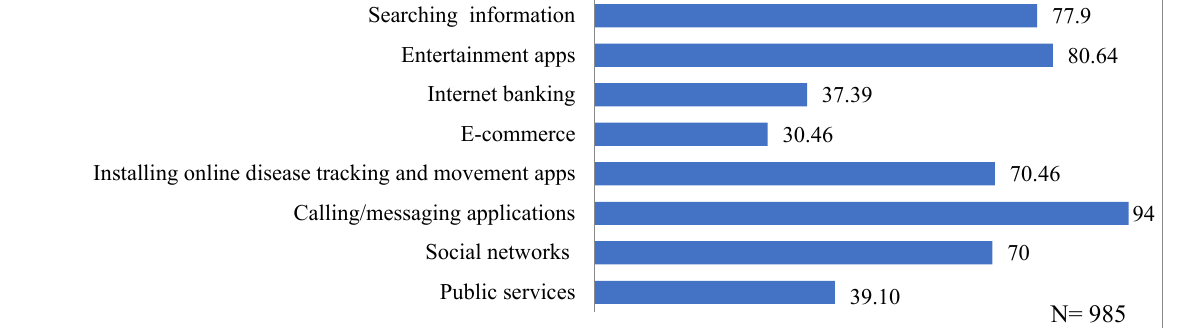
Figure 3. The activeness of the elderly using online applications (% of the Internet-user respond- ents).